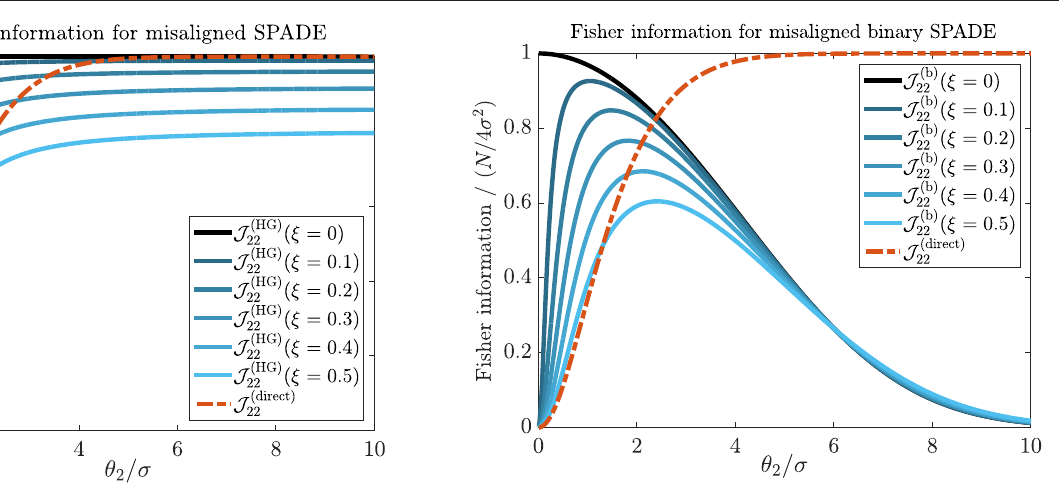
FIG. 12. Fisher information for separation estimation with binary SPADE with misalignment levels ξ ¼ 0 ; 0 . 1 ; … ; 0 . 5 (solid curves) and direct imaging (dash-dotted curve). The different solid curves can be distinguished by their decreasing values with larger